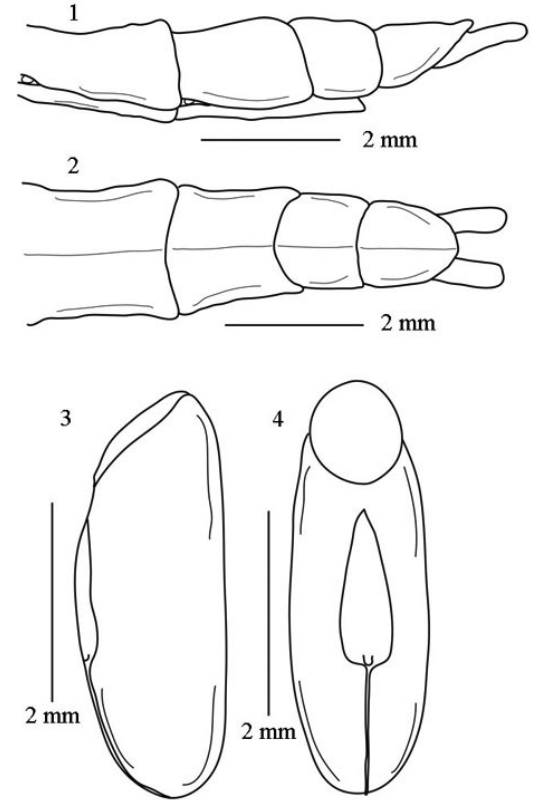
Figs 1–4. Paragongylopus ( Paragongylopus ) cheni sp. n. 1. ♀ , apex of abdomen, lateral view; 2. ♀ , apex of abdomen, dorsal view; 3. Egg, lateral view; 4. Egg, dorsal